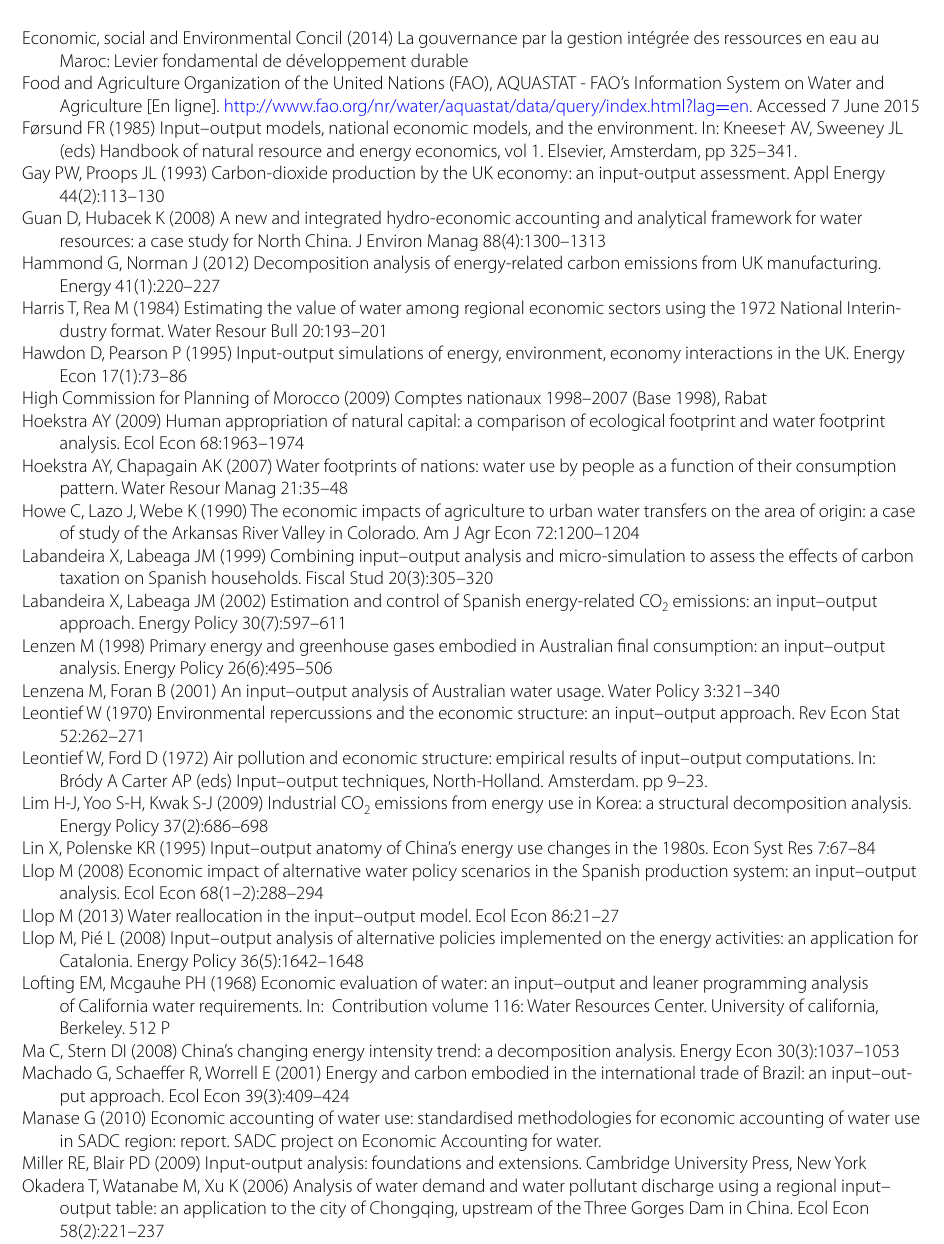
output table: an application to the city of Chongqing, upstream of the Three Gorges Dam in China. Ecol Econ 58(2):221–237 Oliveira C, Antunes CH (2004) A multiple objective model to deal with economy–energy–environment interactions. Eur J Oper Res 153(2):370–385 Oliveira C, Coelho D, Antunes DH (2014) Coupling input–output analysis with multiobjective linear programming models for the study of economy–energy–environment–social (E3S) trade-offs: a review. Ann Oper Res